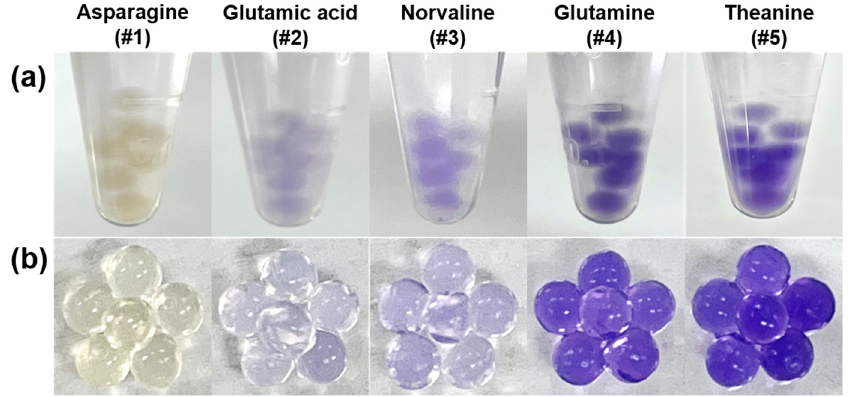
Figure 4. ( a ) Photograph of ninhydrin-loaded microcapsules incubated in the analyte solution of each amino acid (100 mM). ( b ) Photograph of microcapsules upon retrieval from the analyte solution. Because theanine showed the most apparent purple color and RGB intensity among the